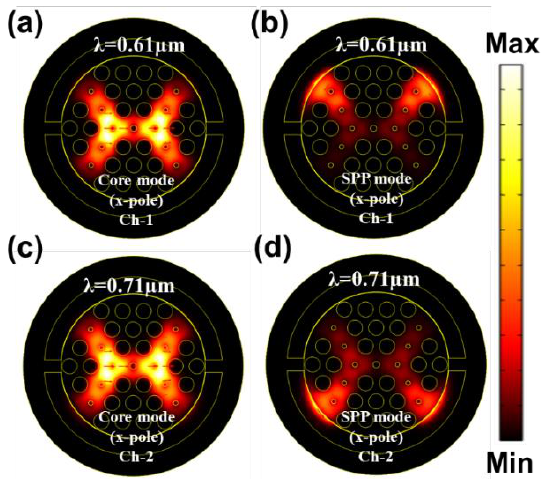
Figure 3. EM field distribution of the core guided mode and the SPP mode for ( a , b ) Ch-1 at RI 1.32 and ( c , d ) Ch-2 at RI 1.36.